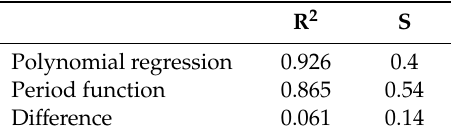
Table 1. Regression analysis evaluation